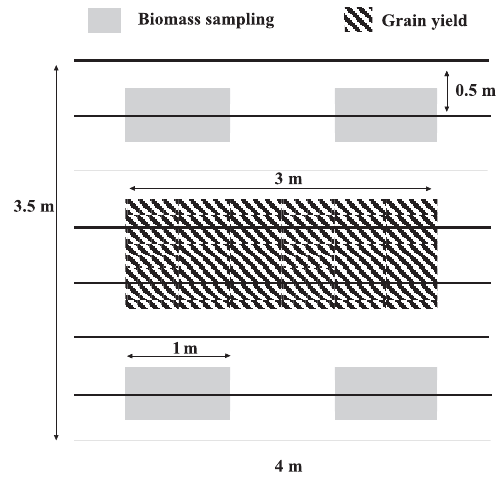
Figure 1. Scheme for biomass sampling and grain yield measurement in field plots with common